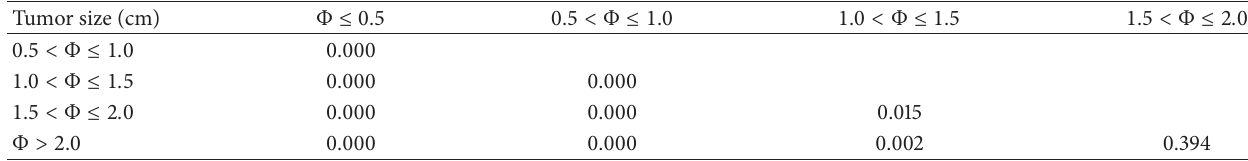
Table 4: The statistical analysis among groups grouped by tumor size.